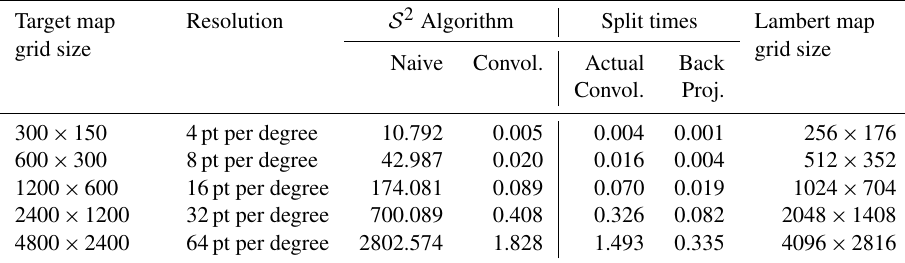
Table 5. Execution times (in s) for the naive and the optimized convolution algorithms using spherical distances on S 2 for varying grid sizes. The number of sample points N = 3490 and the Gaussian width σ = 1 . 0 ◦ are kept constant. The convolution algorithm applied a 4-fold convolution and was executed on a Lambert map grid of the indicated size. The two split time columns show the separated execution times for the actual convolution and the subsequent back projection to the plate carrée map. For the investigated scenarios, the optimized convolution algorithm is more than 1000 times faster than the naive one. S 2 Algorithm Split times Lambert map